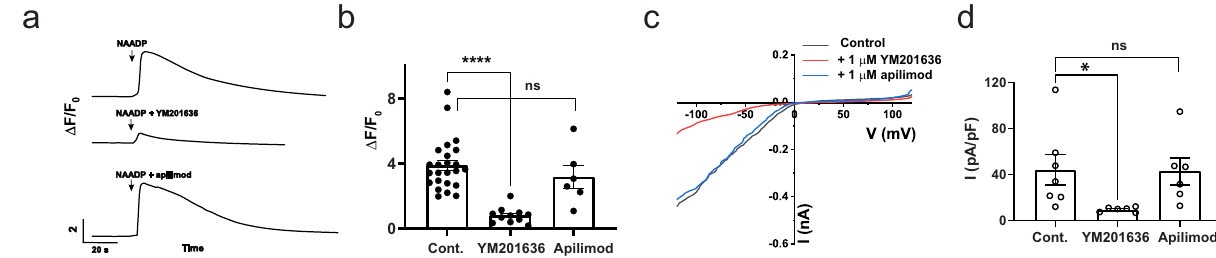
Fig. 1 YM201636 inhibits NAADP-evoked Ca 2 + release and TPC2 activation. a Time course of NAADP (microinjection)-induced change in fl uorescence of Ca 2 + indicator in TPC2-expressing HEK293 cells. NAADP (100 nM), YM201636 (1 µ M), and apilimod (1 µ M) were included in the injection pipette solution and applied inside cells via microinjection. b Averaged NAADP-induced changes in Ca 2 + indicator fl uorescence in TPC2-expressing HEK293 cells. c Averaged traces of NAADP (1 μ M in pipette solution) microinjection-induced whole cell currents in HEK293 cells transfected with TPC2 PM mutant construct. YM201636 (1 µ M) and apilimod (1 µ M) were incubated with cells in bath solution for ~ 10 min before recording. d Averaged current density of NAADP microinjection-induced whole cell TPC2 PM currents at − 120 mV. The averaged data are presented as mean value ± SEM. Unpaired Student ’ s t -test (two tailed) was used to calculate p values. ****, *, and ns are for p values ≤ 0.0001, 0.05, and > 0.05,